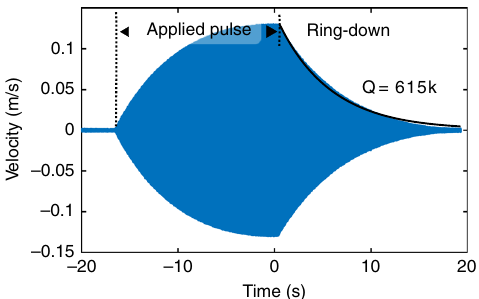
Fig. 2 Measured ring-down waveforms with the modulation electrical relay closed. Waveform taken in a vacuum background at 150 mV peak